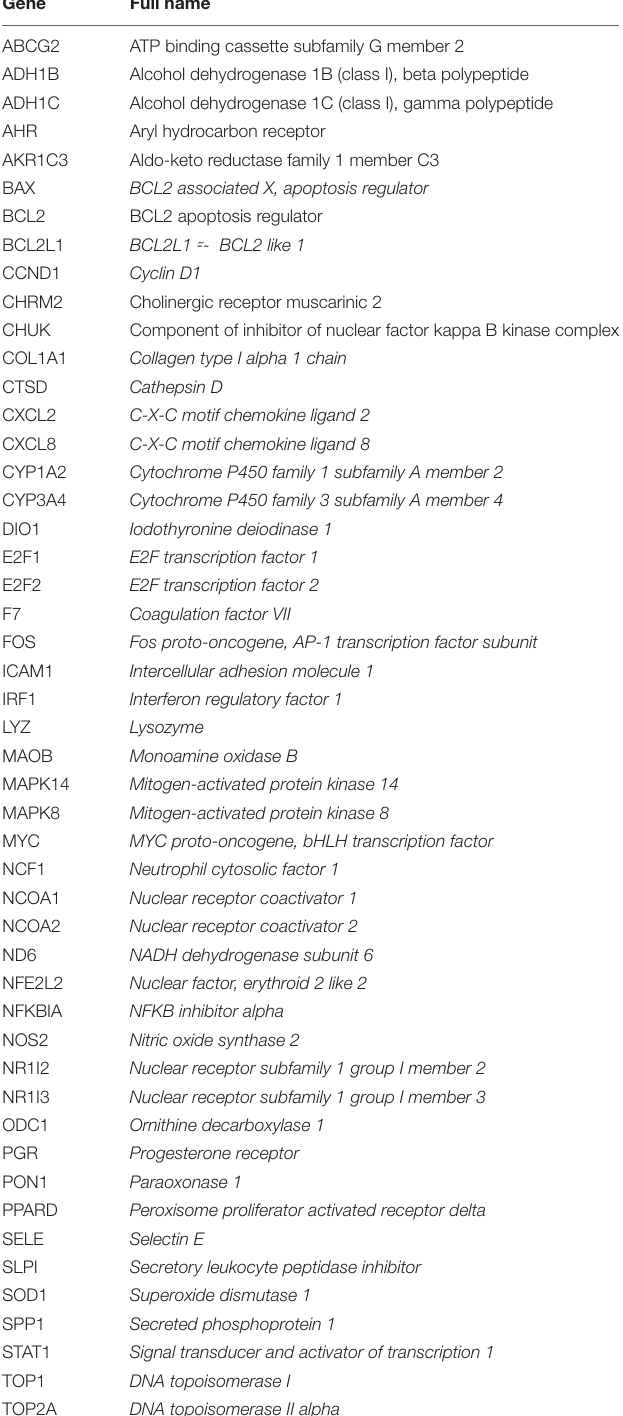
TABLE 2 | The potential hub genes of Astragali Radix (AR) against acetaminophen-induced liver injury